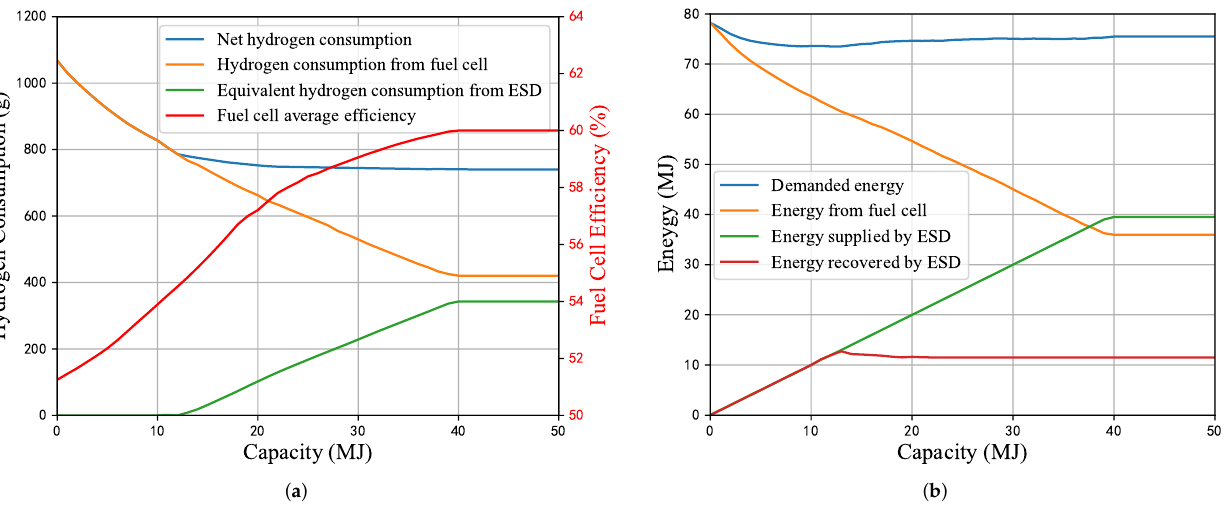
Figure 7. ( a ) The relationship between ESD capacity and hydrogen consumption. Net hydrogen con- sumption is the sum of hydrogen consumed from the fuel cell and equivalent hydrogen consumption from ESD. Fuel cell average efficiency is defined to represent the conversion rate of hydrogen gas E fc over the entire operation. It is calculated by η ef f = . ( b ) The relationship between ESD capacity H · m fc and energy flows between different components. The demanded energy is the energy required for train traction, which is the sum of the energy output of the fuel cell and